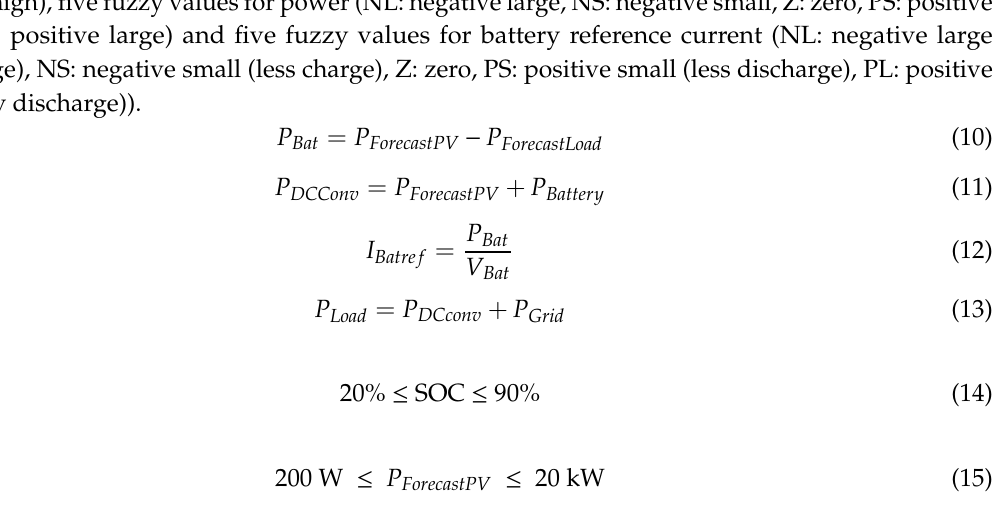
Figure 8. The fuzzy sets of ( a ) SoC (state of charge), ( b ) power and ( c ) battery current. Table 7. Fuzzy rule table.